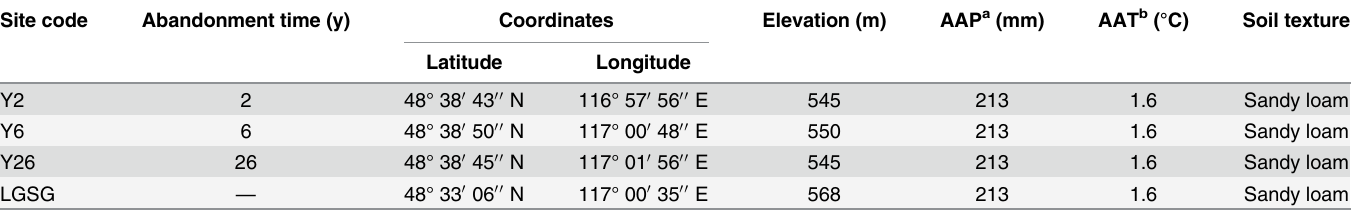
Table 1. Characteristics of the study